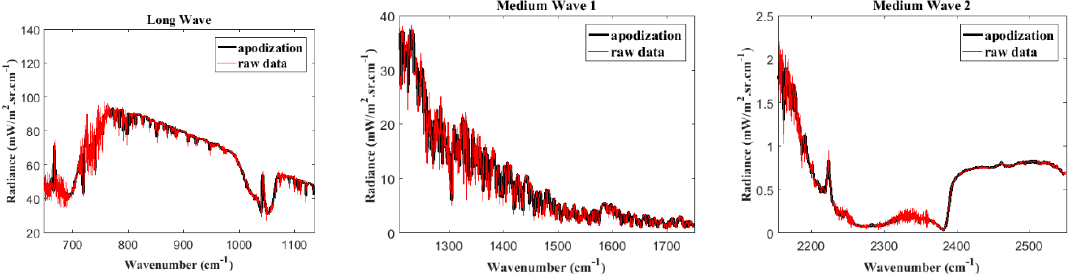
Figure 2. The influence of apodization on satellite receiving radiation. From left to right is long wave medium wave 1, and medium wave 2. The black line shows the radiation after apodization, while the red one represents the raw radiation.